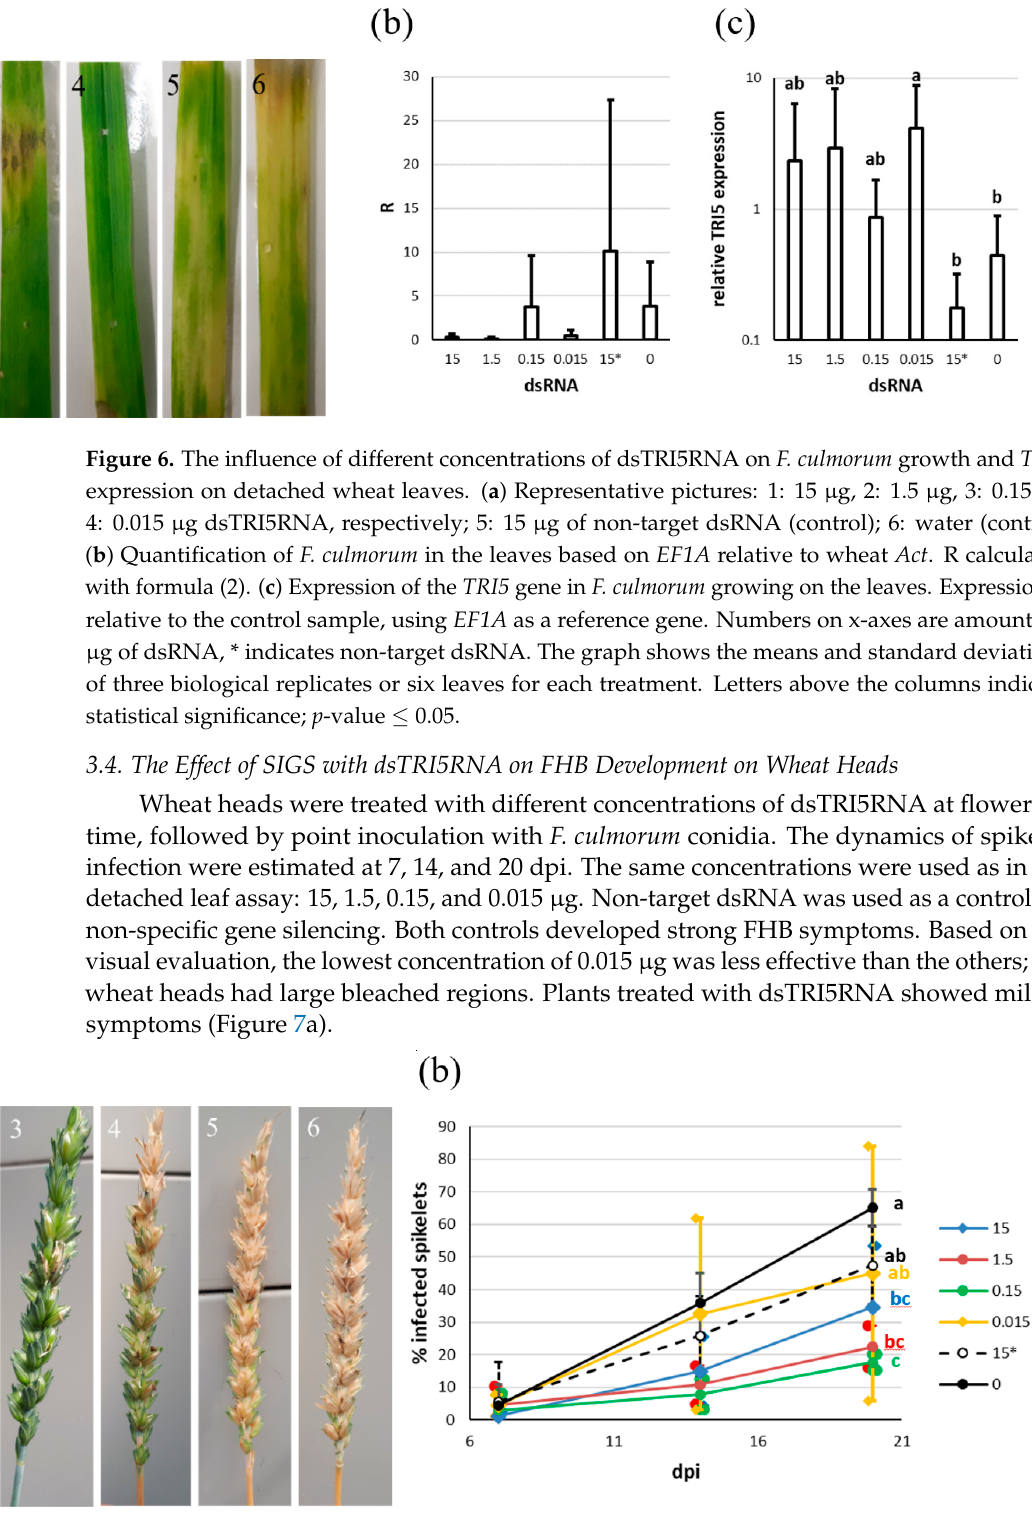
Figure 7. FHB after spraying with various amounts of dsTRI5RNA. ( a ) Representative pictures: 1: 15 µg, 2: 1.5 µg, 3: 0,15 µg, 4: 0,015 µg, respectively; 5: 15 µg of non-target dsRNA (control); 6: water (control). ( b ) Dynamics of spikelet infection. The graph shows the percentage of infected spikelets at 7, 14, and 20 dpi, means and standard deviations (see 2.10 for sample sizes). Numbers in the legend indicate the different amounts of dsTRI5RNA in µg; * indicates non-target dsRNA. Letters to the right of the graphs indicate statistical significance; p -value ≤ 0.05.